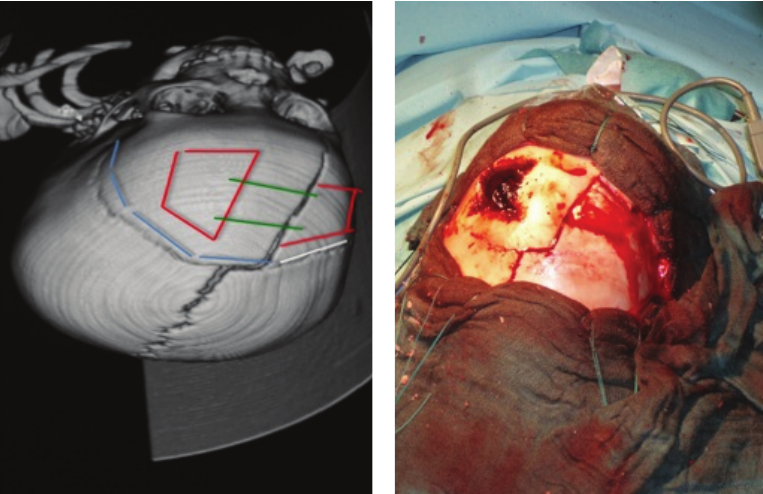
Figure 3: Scheme of incision for operative course and peroperative view.